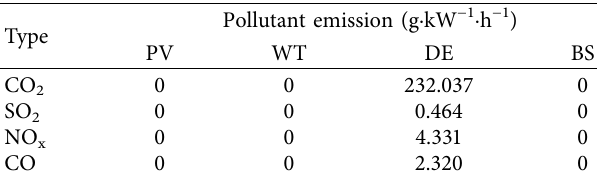
Table 2: Pollutant emission coefficients of different generation units.